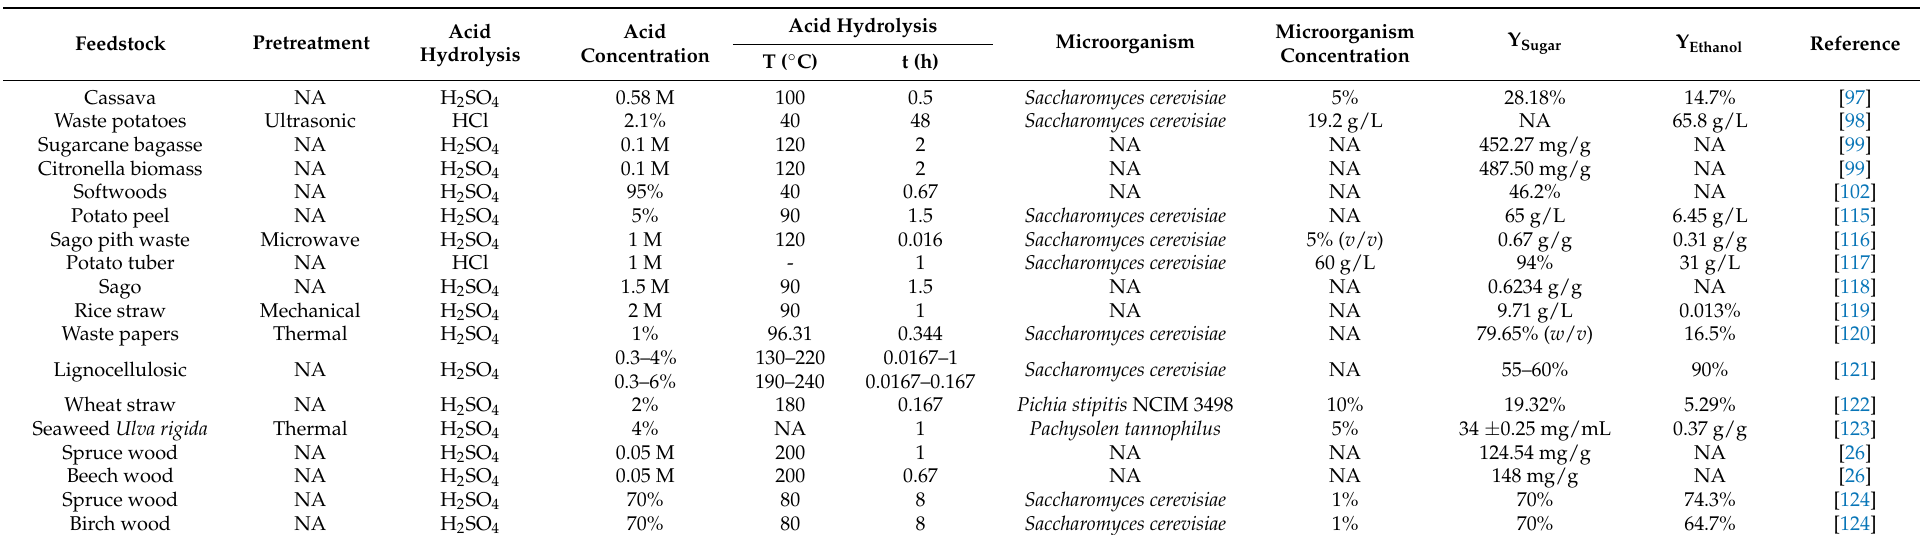
Table 4. Acid hydrolysis with various biomass